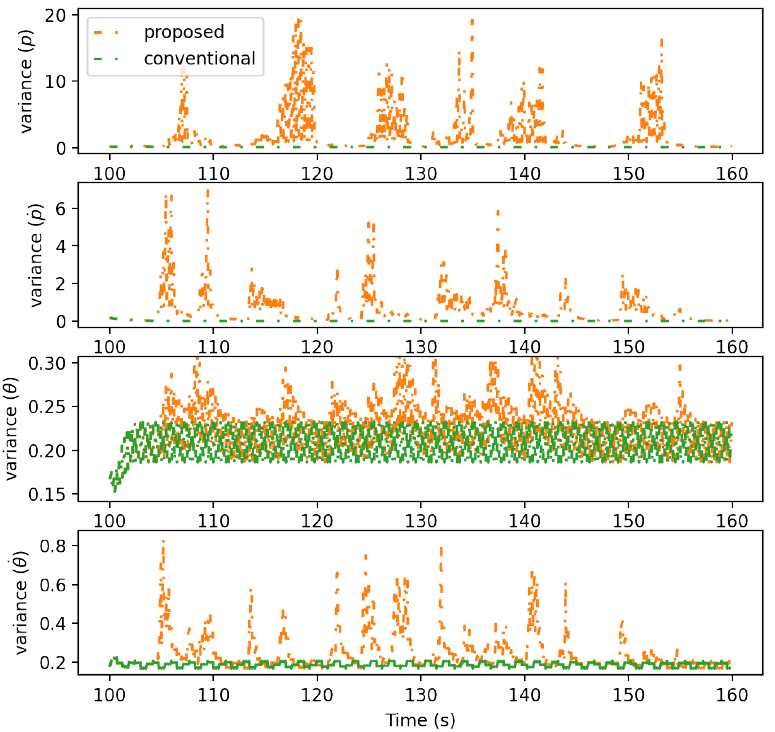
Figure 14. Variance estimated by the proposed and the conventional